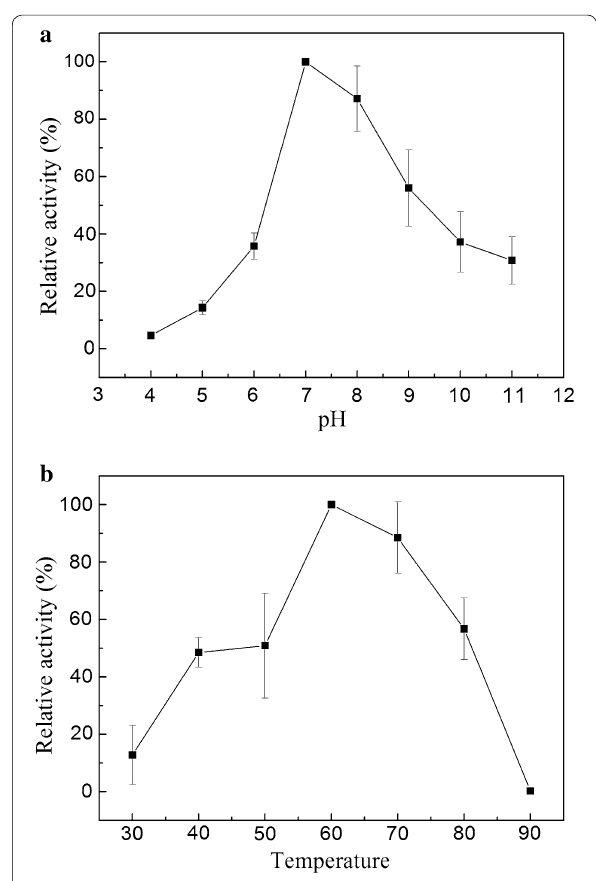
Fig. 3 Effects of a pH and b temperature on the activity of purified recombinant Bgl.bli1